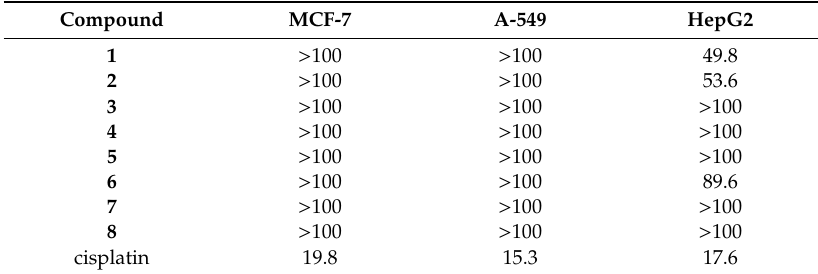
Table 2. Cytotoxicity of compounds 1 – 8 (IC 50 , µ